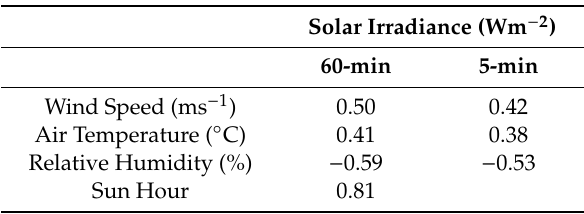
Table 3. Correlation ratios of weather factors with solar irradiance.